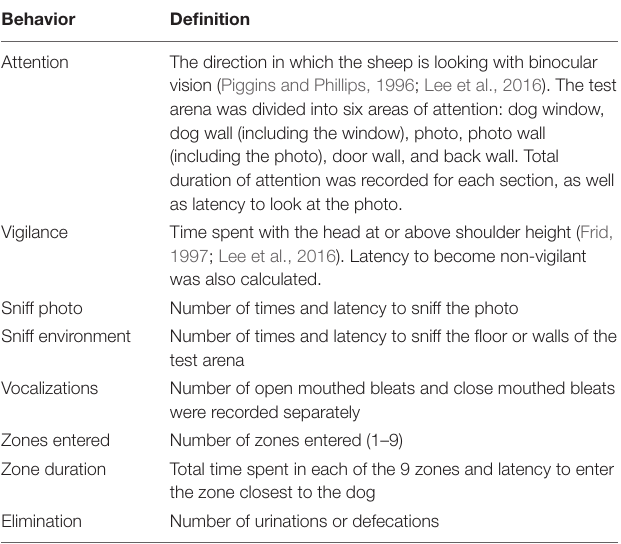
TABLE 2 | Ethogram of behaviors recorded during the attention bias